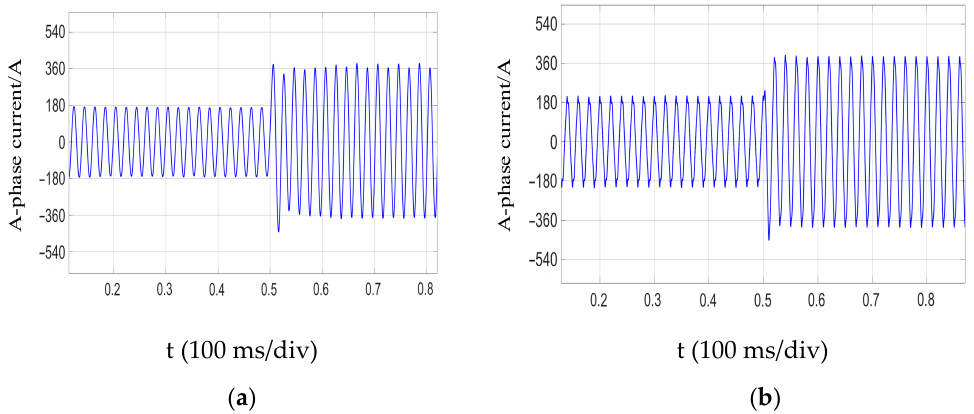
Figure 11. A-phase current waveform when the load suddenly decreases: ( a ) Controlled by backstepping control method; ( b ) Controlled by SMVS.